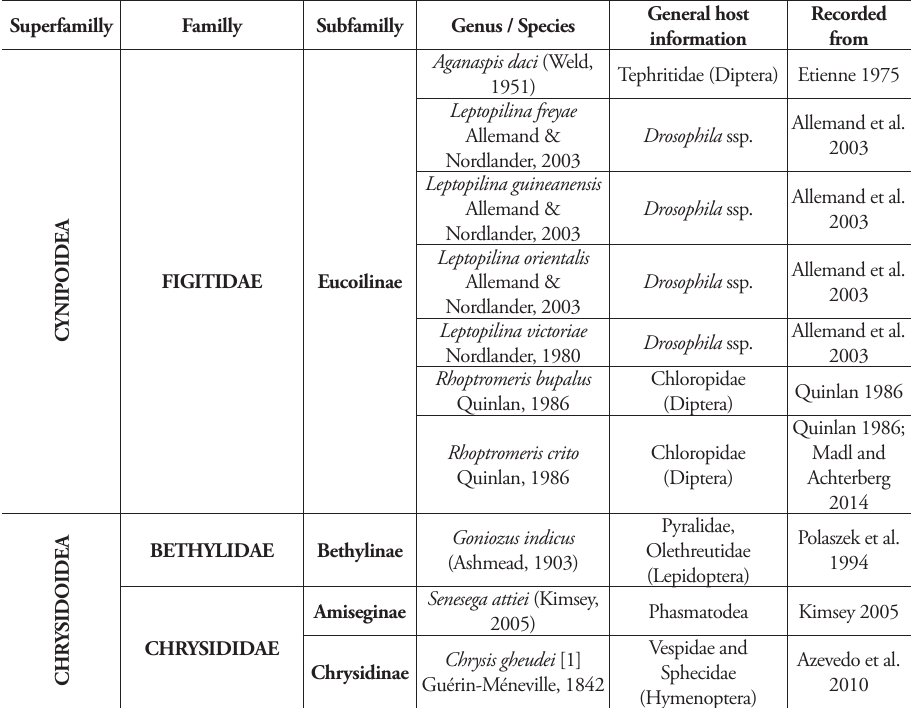
General host Recorded information